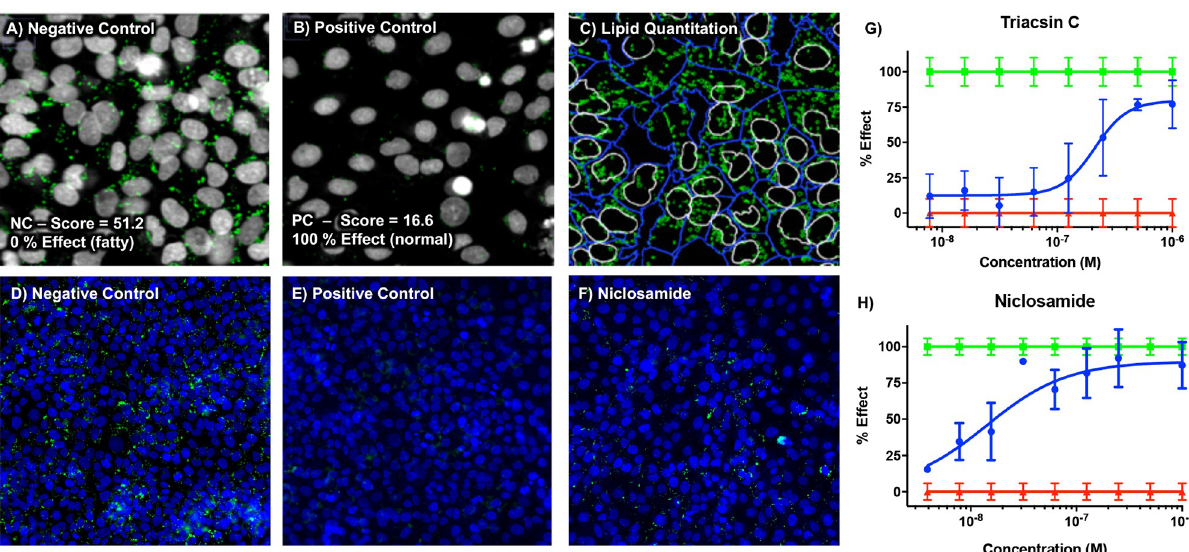
Fig 1. High content lipid quantitation in PH5CH8 liver cells. Negative control cells stimulated for de novo lipid synthesis showing nuclei (gray) and lipids (green) (A) and lipid quantitation of negative control using high-content image analysis resulting in a high lipid score, normalized to 0% effect (C) Positive control—unstimulated cells representing the normal (basal) lipid content with a low lipid score and normalized to 100% effect (B). Representative images from high throughput screening showing negative (D) and positive (E) control wells and stimulated cells treated with 1 μ M niclosamide (F). Dose response analysis of test compounds Triacsin C (G) and niclosamide (H) shown in blue. Green and red lines represent the mean and standard error of stimulated and unstimulated cells.